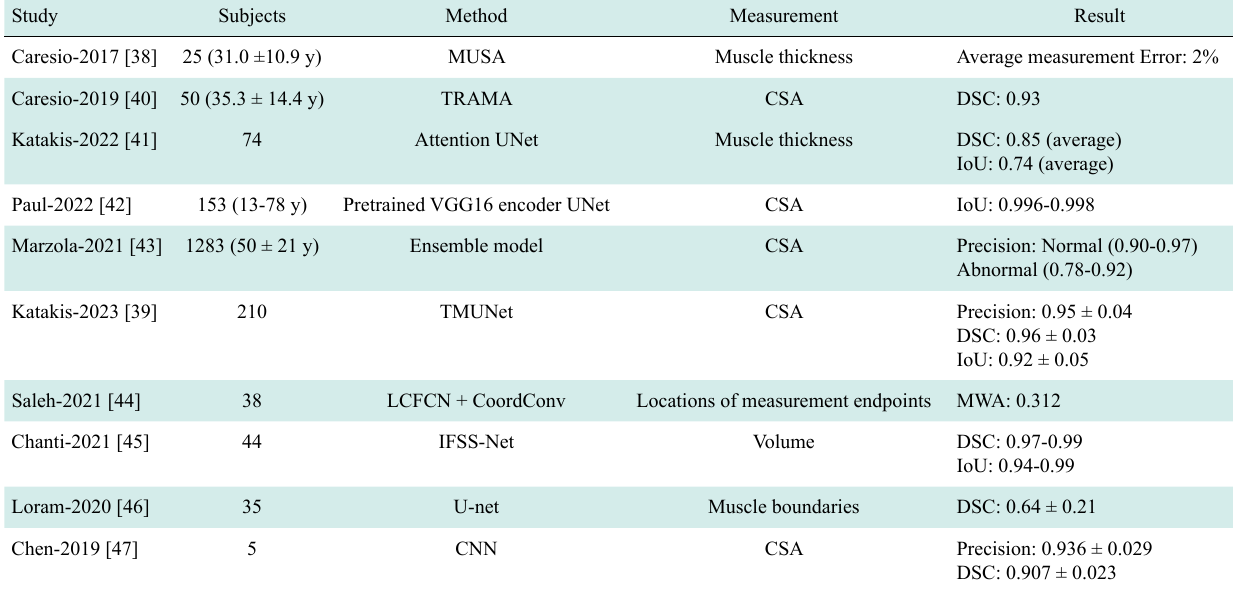
Table 1 Summary of AI image segmentation in muscle ultrasound